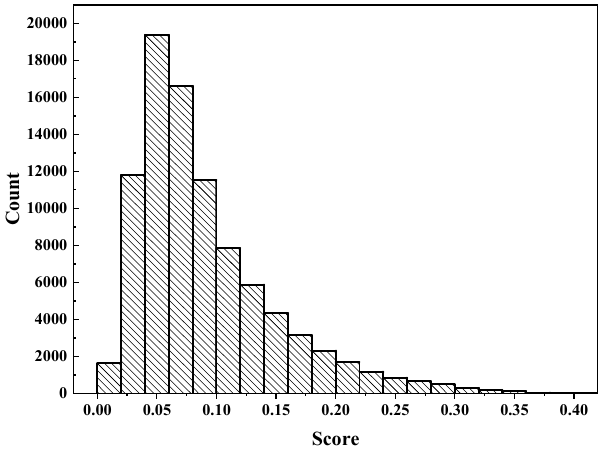
Figure 8. Frequency distribution of target value.